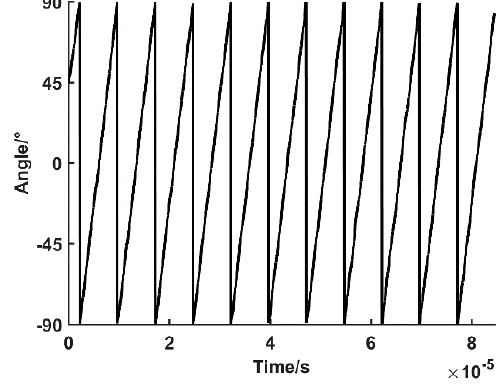
Figure 7. Overflowing handling of the tangent value of encoder output.